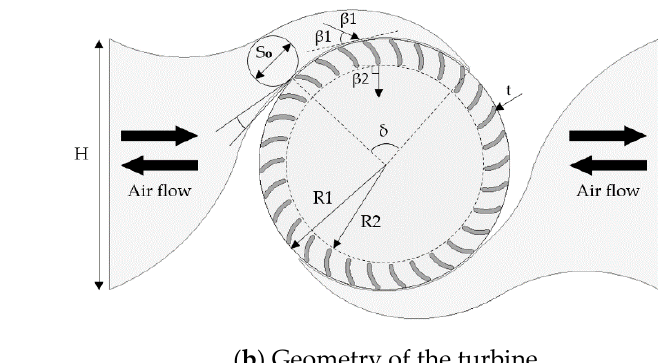
Figure 1. Schematic of the cross-flow air turbine. Table 1. Detailed design parameters of the cross-flow air turbine numerical model.